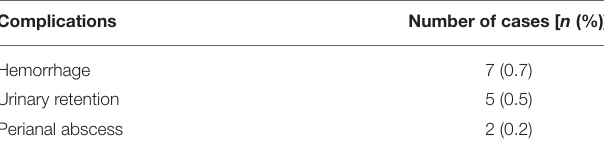
FIGURE 3 | Direction of the second injection.